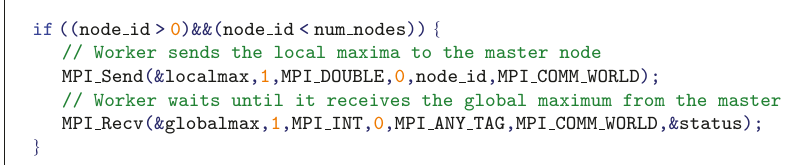
Figure 5: Portion of the code of a worker in our P-ATDCA implementation, in which the worker sends a precomputed local maximum to the master and waits for a global maximum from the master.